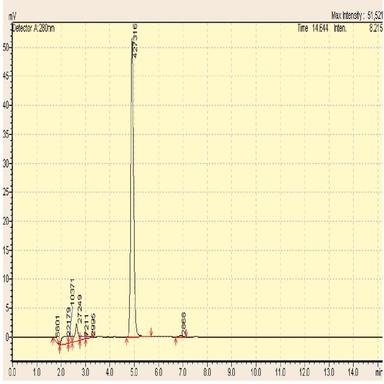
EC formulation: Trinexapac ethyl in pristine form by GC-MS/MS a) and by HPLC-DAD b).